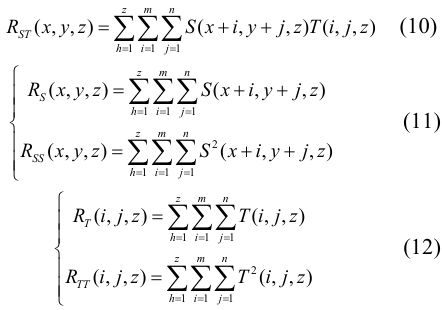
Figure 3. Illustration of the constructed descriptor utilizing different Gaussian convolution strategies. (a) SAR image. (b) optical image. (c) Heatmap of the original image pairs. (d) Heatmap of the SFOC features without Gaussian convolution. (e) Heatmap of the SFOC features with the general Gaussian convolution. (f) Heatmap of the SFOC features with parallel Dilated Gaussian